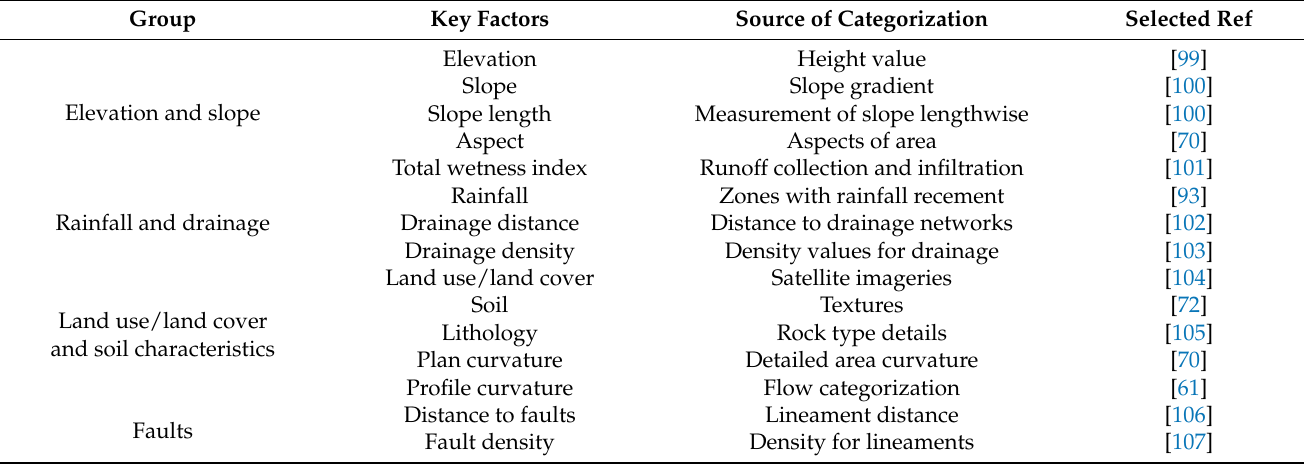
Table 2. Factors influencing groundwater recharge classified